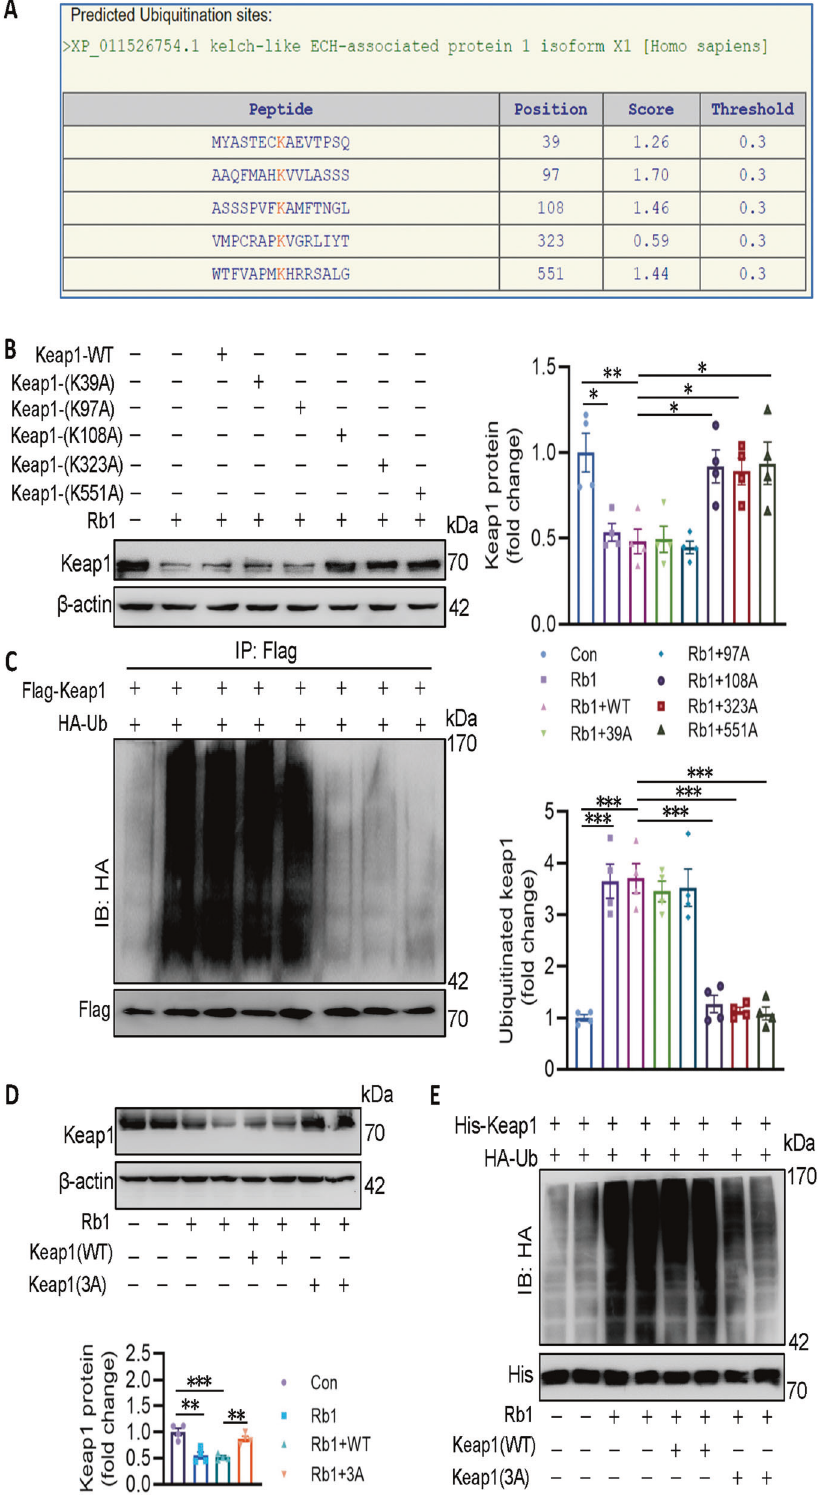
Fig. 6 Rb1 promotes SYVN1-mediated keap1 ubiquitination at K108, K323, and K551. A The ubiquitination sites of Keap1 predicted by the BDM-PUB database. B HEK293T cells were transfected with indicated Keap1 mutation plasmids for 48h, the cells then treated with Rb1 for 24h, cell lysates were then immunoblotted to quantify Keap1 protein levels. C Effects of different Keap1 mutation plasmids on the ubiquitination levels of Keap1 induced by Rb1 in HEK293T cells. D HEK293T cells were transfected with Keap1-(K108A), Keap1-(K323A), and Keap1-(K551A) plasmids for 48 h, the cells then treated with Rb1 for 24h, cell lysates were then immunoblotted to quantify Keap1 protein levels. E Effects of Keap1-(K108A), Keap1-(K323A), and Keap1-(K551A) plasmids on the ubiquitination levels of Keap1 induced by Rb1 in HEK293T cells. Data are presented as mean ± SEM. n = 4. Statistical analysis was performed with the randomized block ANOVA. * P < 0.05; ** P < 0.01; *** P < 0.001; vs . indicated group.